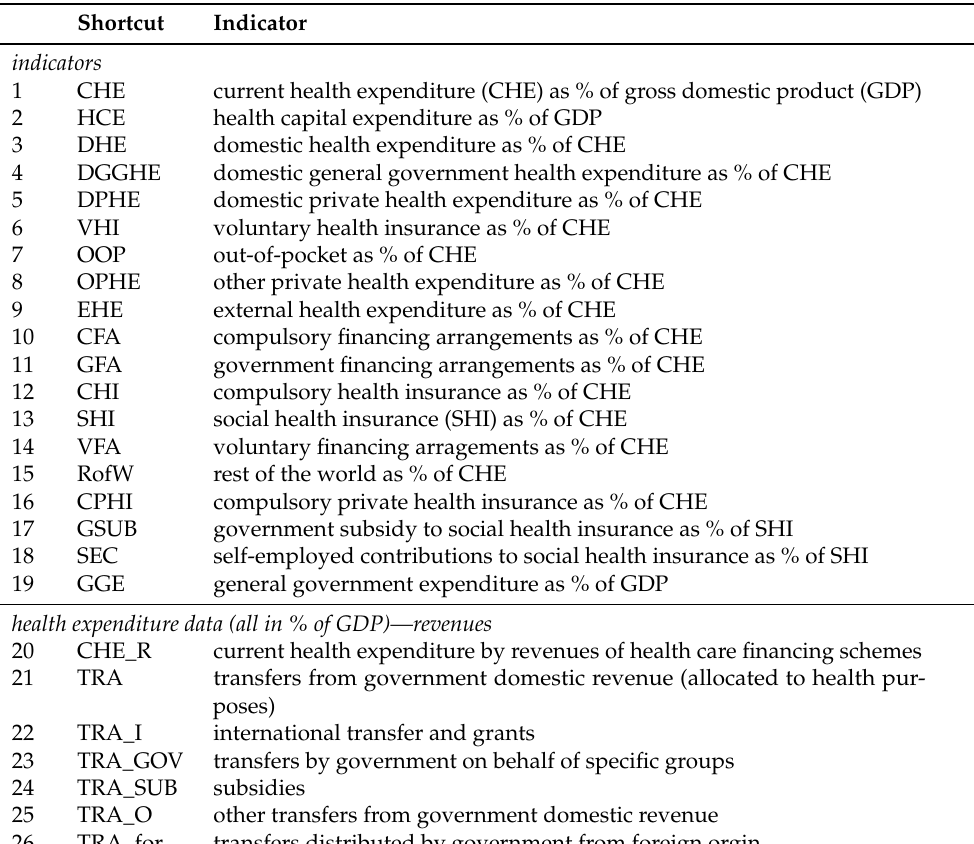
Table 1. GHED indicators with reference and shortcut used to create the